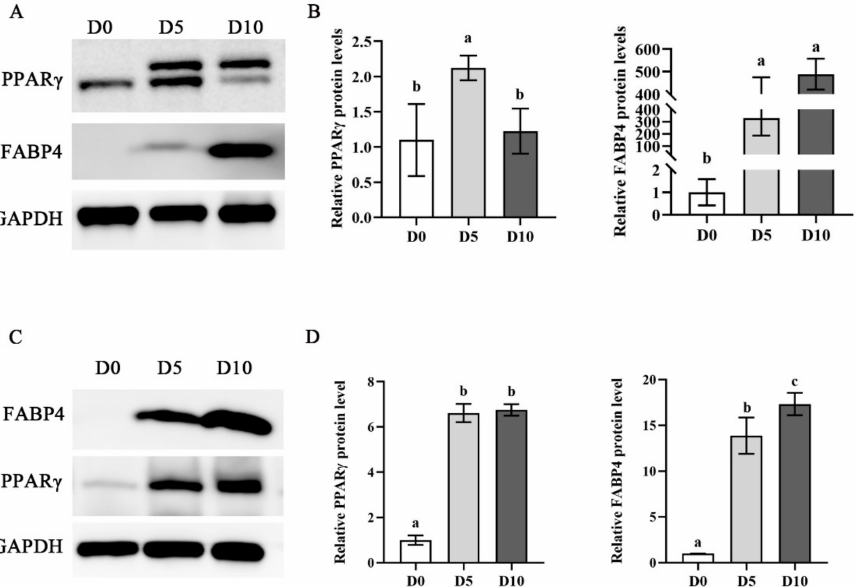
Figure 6. Validation of adipogenic differentiation ability of ADSCs after expansion on MCs. ( A ) Western blot analysis of the expression of adipogenic differentiation of marker proteins PPAR γ and FABP4 for 2D surface culture. ( B ) Quantitative adipogenic differentiation of marker proteins PPAR γ and FABP4 for 2D surface culture. ( C ) Western blot analysis of the expression of adipogenic differentiation of marker proteins PPAR γ and FABP4 for 3D culture. ( D ) Quantitative adipogenic differentiation of marker proteins PPAR γ and FABP4 for 3D culture. Statistical testing: a–c, different letters in the same columns indicate significant differences. p < 0.05, and error bars indicate